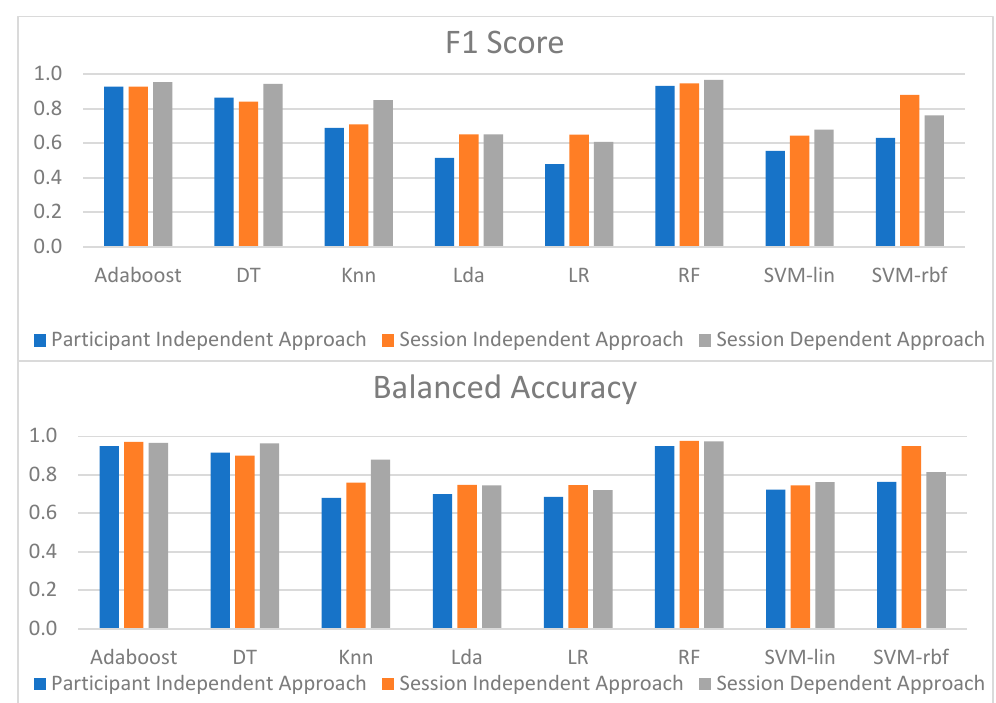
Figure 14. Obtained F1 ( top ) and balanced accuracy ( bottom ) from all models using the three different approaches.